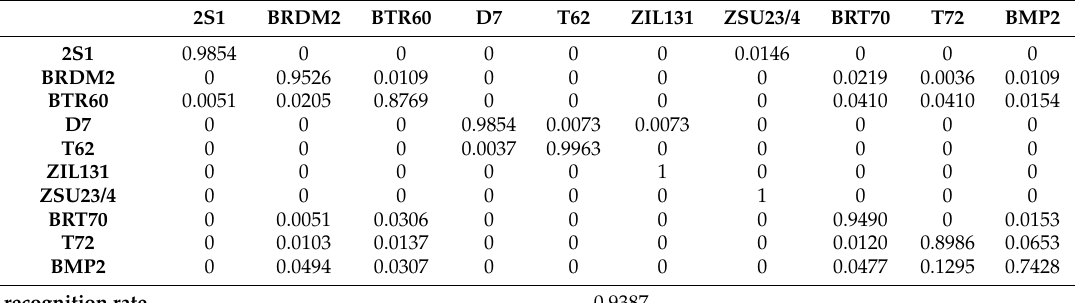
Table 13. The result of SVM based on SAR-HOG under SOC.